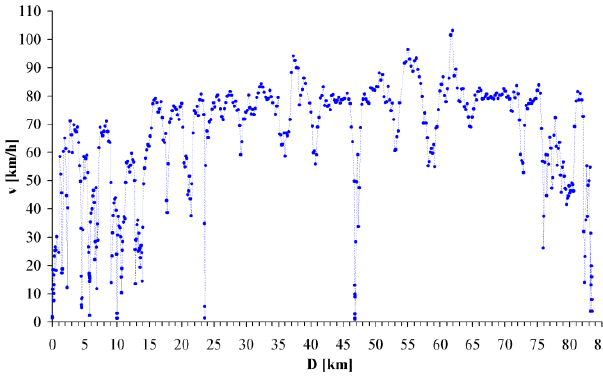
Fig. 13. Speed of travel at individual stages of the route during the exem- plary run During all the runs, the indications of the indicator were recorded every half a second. Examples of indications dur- ing the run in which the driver did not use the indicator (the indicator was covered) are shown in Fig. 14a. Figure 14b shows an example of an indication during which the driver uses the indicator.